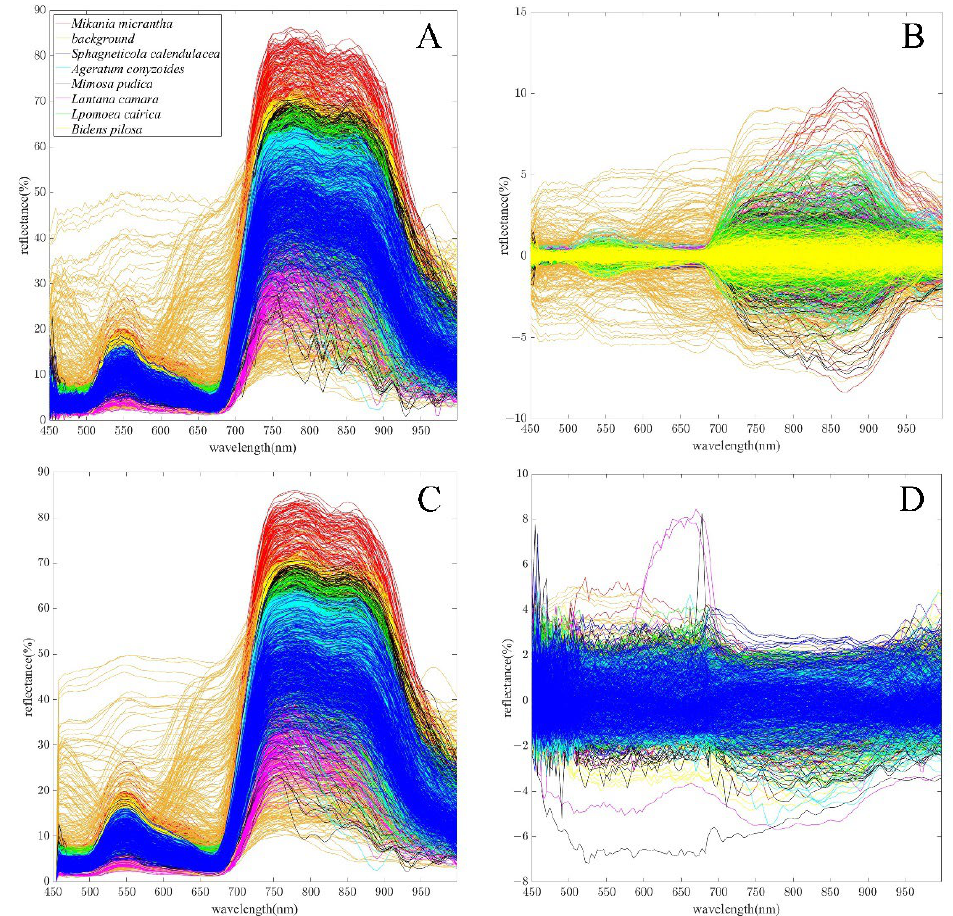
Figure 3. Raw spectral curve of 3359 samples ( A ), raw spectral curve, preprocessed by ( B ) first derivative, ( C ) SG smoothing, ( D ) standard normal variate.